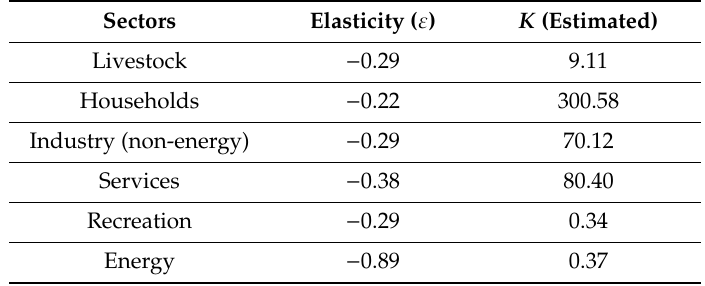
Table 3. Estimated parameters for sectoral water demand. Guadalquivir